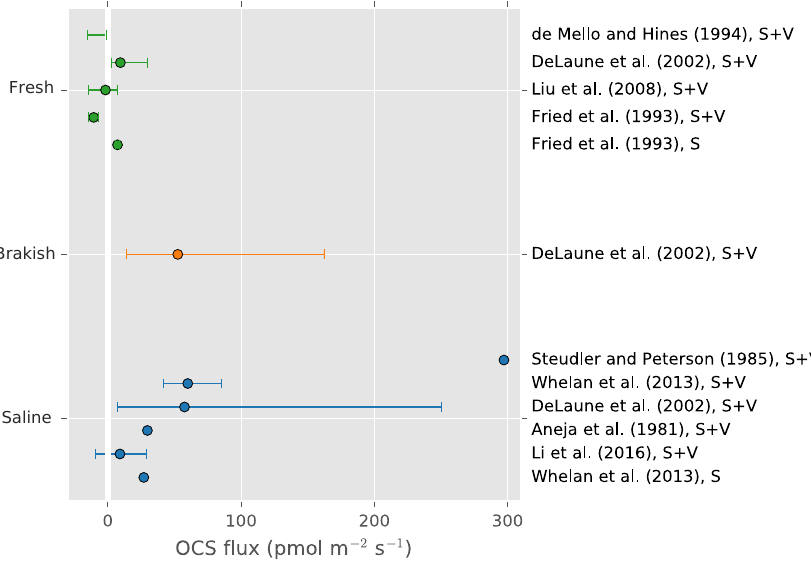
Figure 4. A summary figure for wetland OCS emissions. Lines indicate minimum to maximum ranges. Studies denoted “S” indicated a soil-only observation, and “S + V” denotes a soil and vegetation observation. Points show reported averages, and error bars show either reported uncertainty or the full range of observations. Note that some earlier observations using sulfur-free air as chamber sweep air have been excluded due to overestimation (Castro and Galloway, 1991).